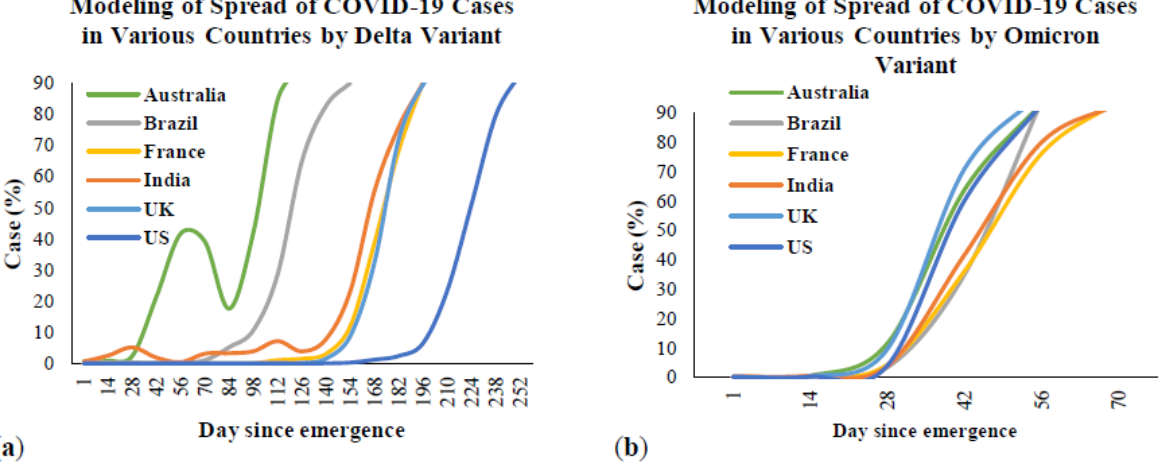
Figure 10. Comparison between Delta and Omicron outbreaks in the most affected countries and Australia: ( a ) cases by Delta variant; ( b ) cases by Omicron variant.